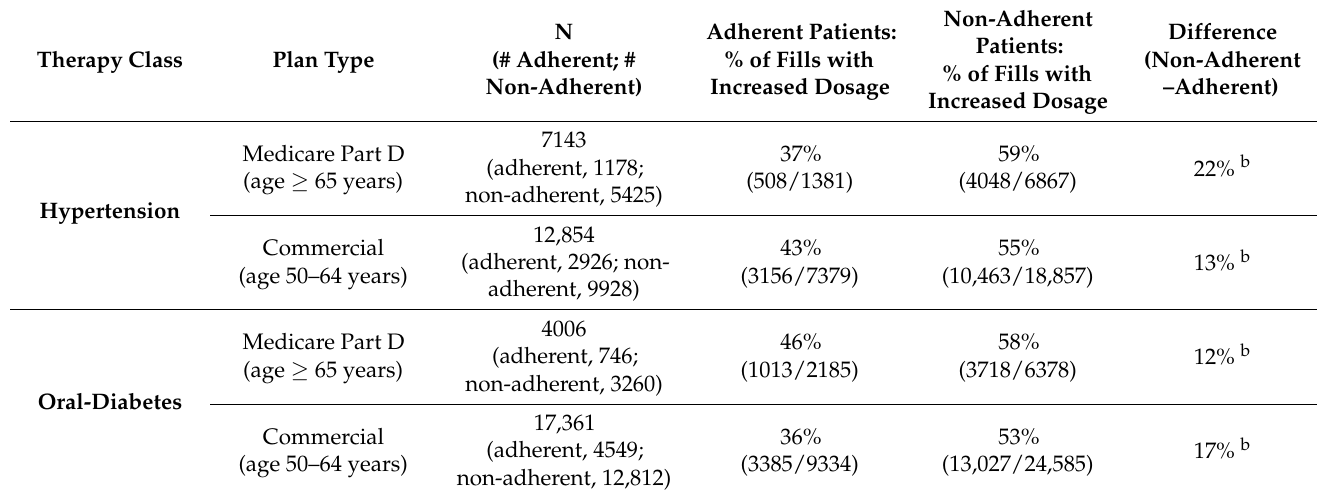
Table 2. Difference in increased dosages between adherent and non-adherent patients a